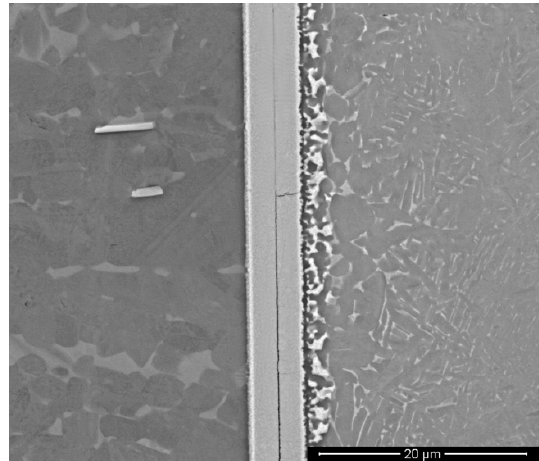
Figure 1. Scanning electron microscopy (SEM) image of a TiAl/Ti6Al4V interface produced at 700 °C under a pressure of 20 MPa using Ni/Al nanolayers.